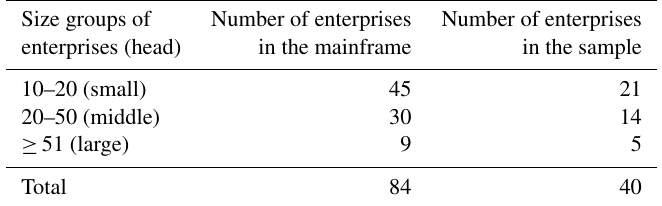
Table 2. Number of sample enterprises by enterprise size